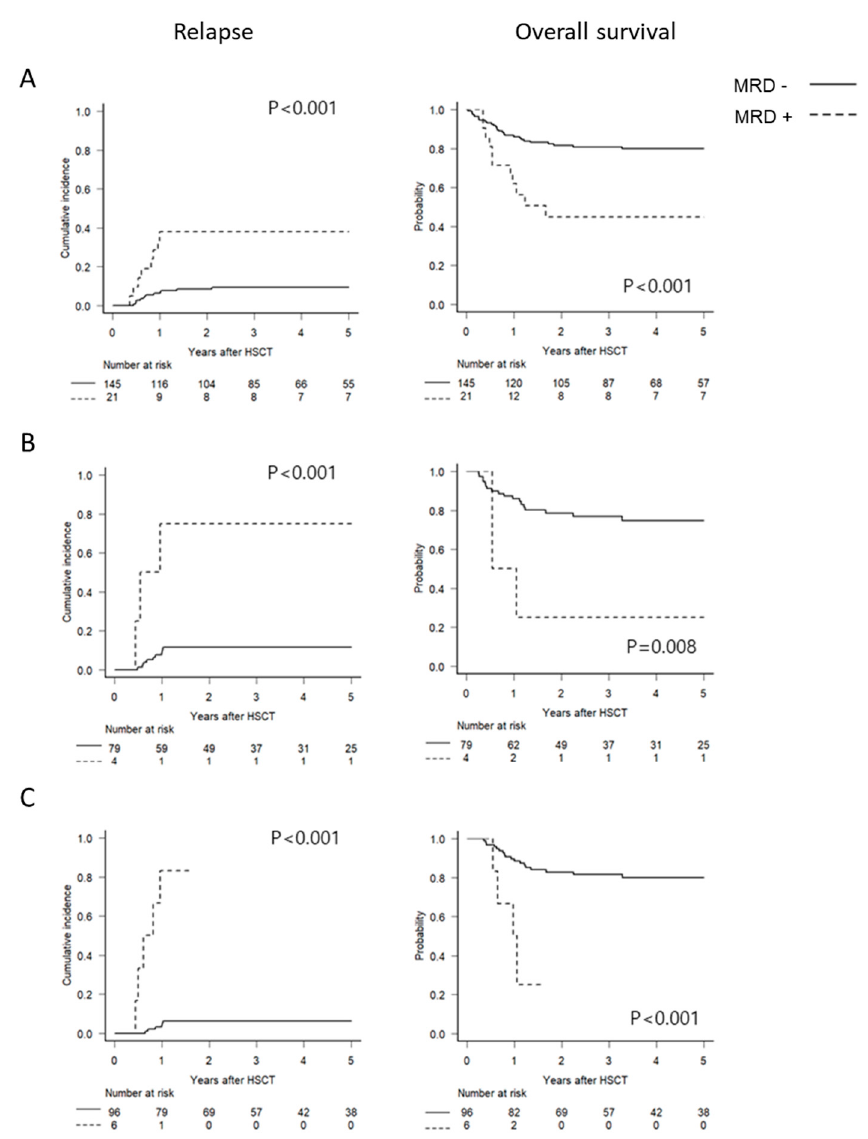
Figure 3. Survival outcomes according to MRD positivity defined by 3 log reduction in RUNX1– RUNX1T1 levels at pre-HSCT ( A ) and at 1 month ( B ) or 3 months ( C ) after HSCT.